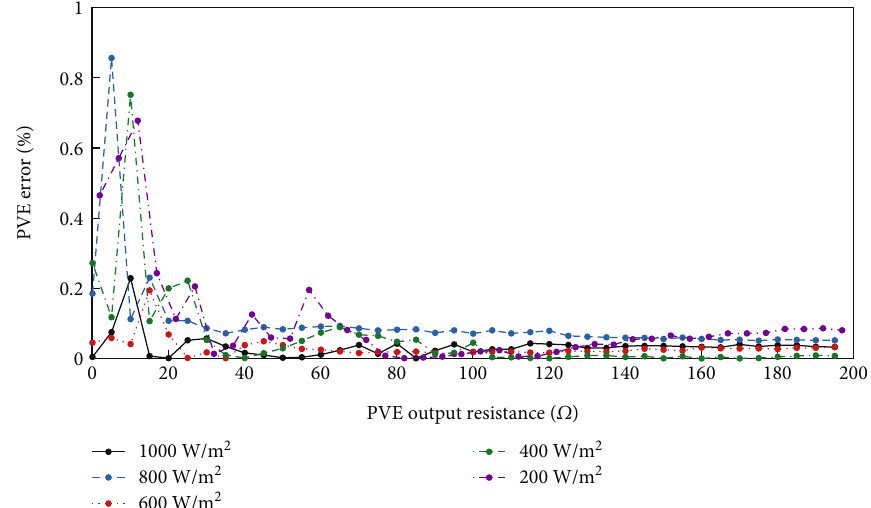
Figure 12: Accuracy of the PVE, measured by the relative error as a function of the output resistance for varying irradiance and constant temperature ð 25 ° C Þ